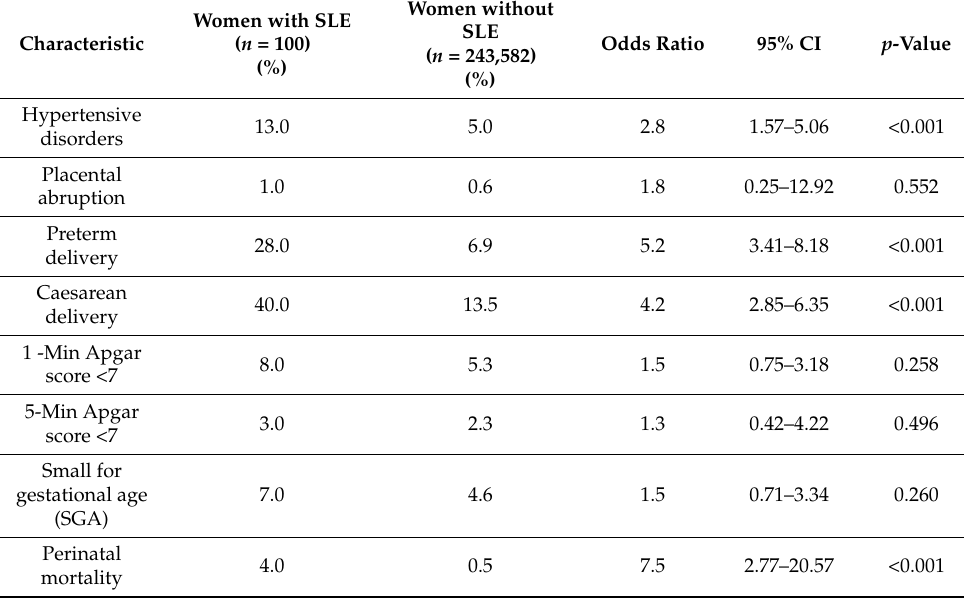
Table 2. Perinatal outcomes of women with and without SLE.